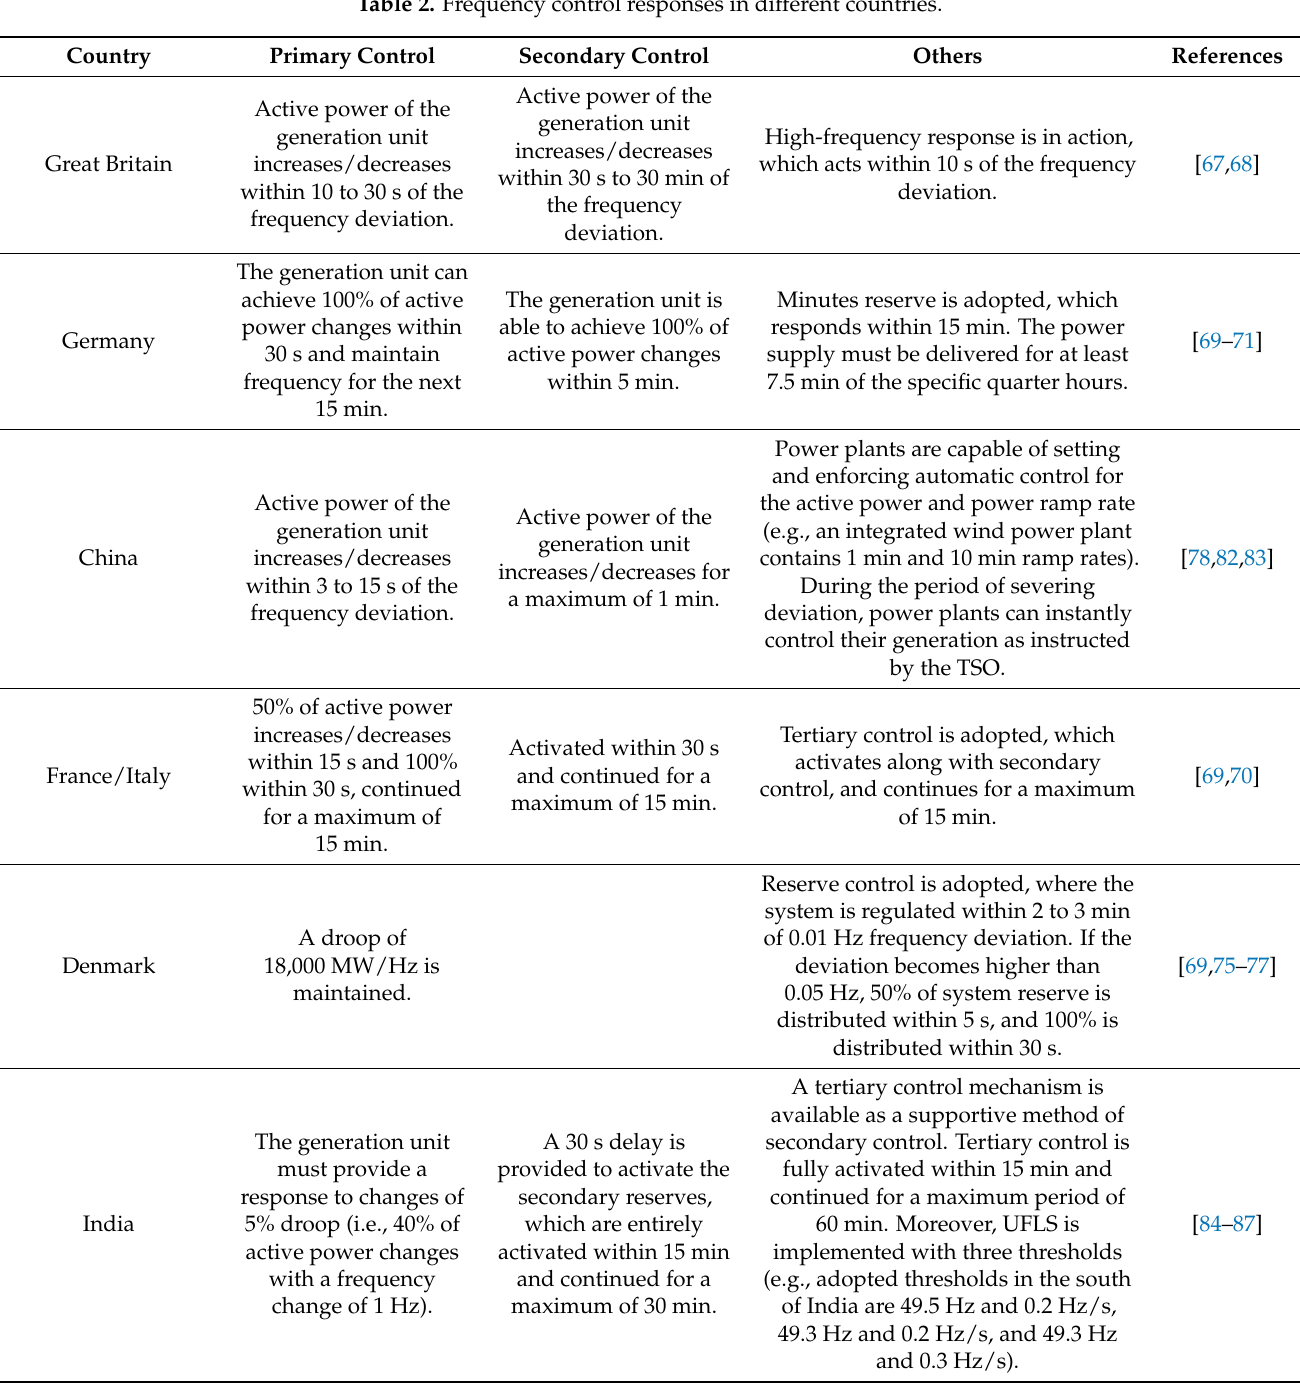
Table 2. Frequency control responses in different